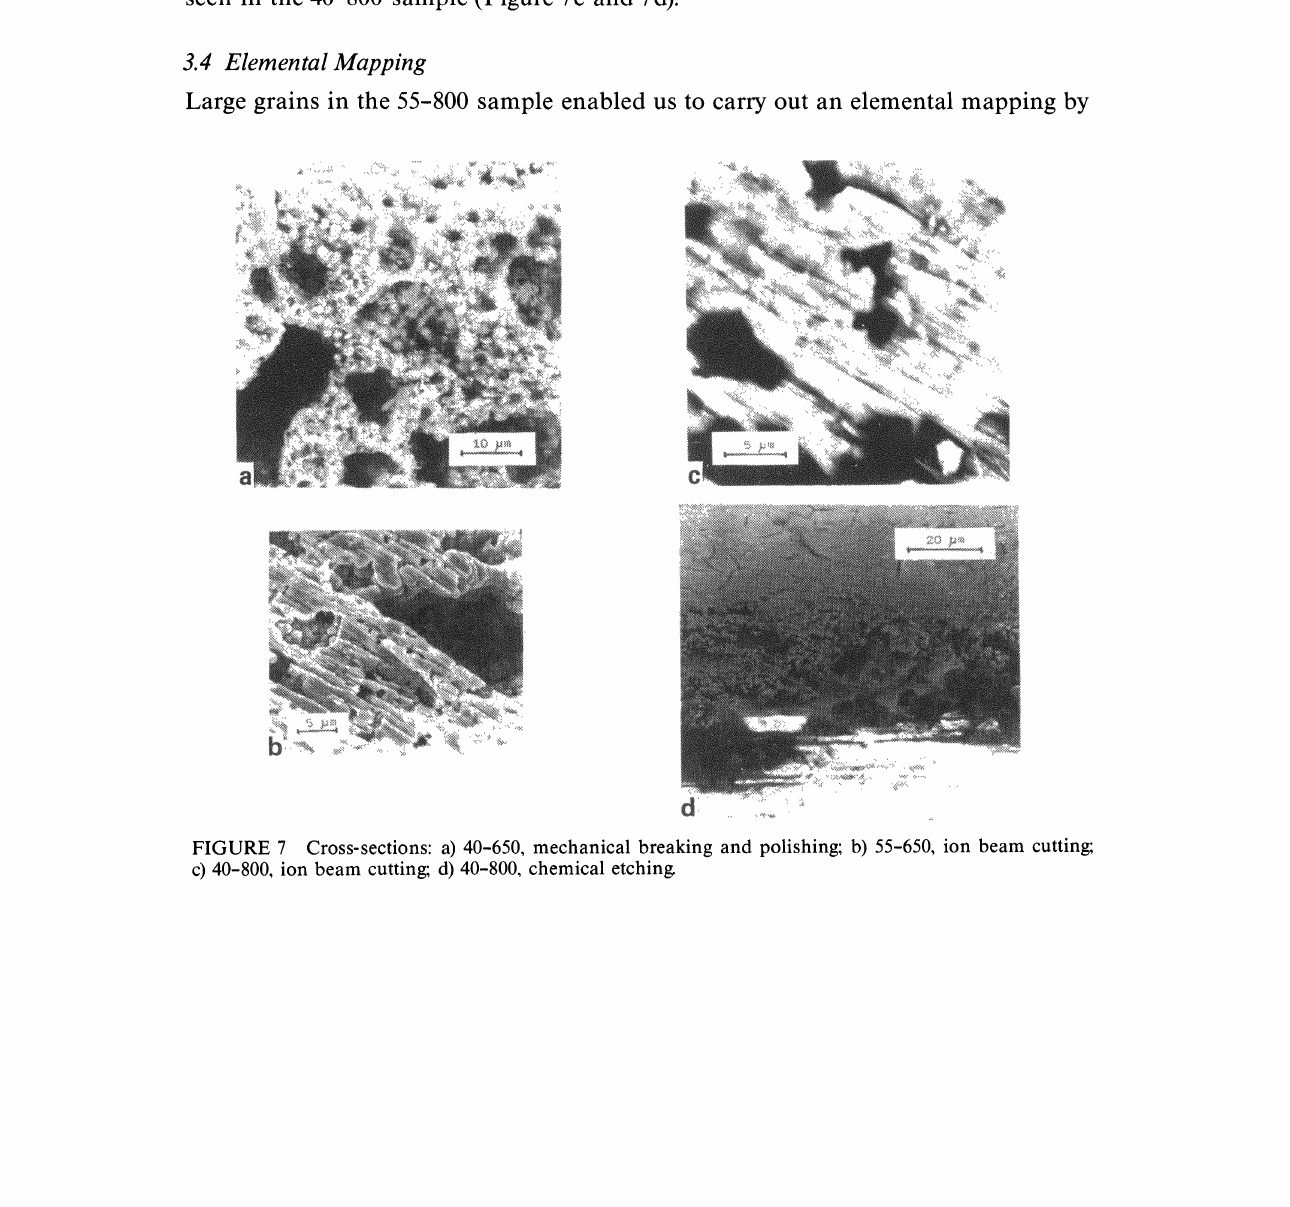
FIGURE 6 Chemically etched surfaces, a) 40-650, b) 40-800.